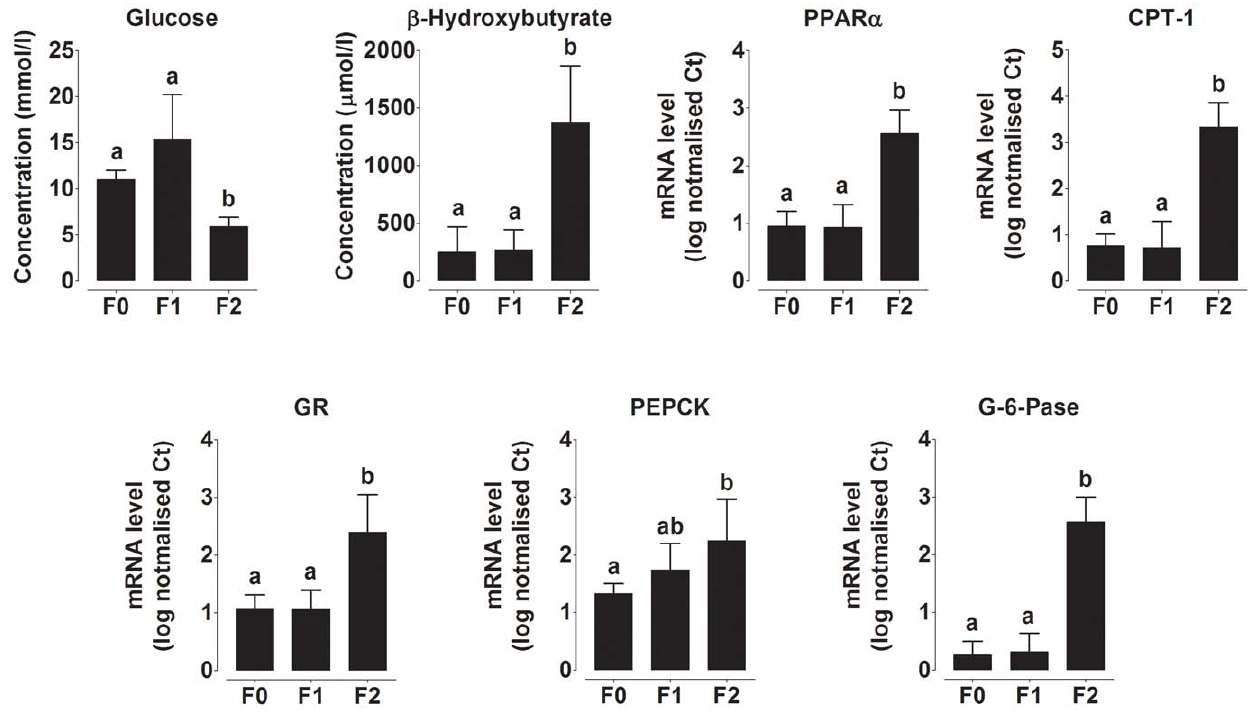
Figure 3. Maternal blood metabolite concentrations and mRNA expression of genes involved in hepatic gluconeogenesis and ketogenesis. Plasma fasting glucose and b -hydroxybutyrate concentrations. Hepatic PPAR a , carnitine palmitoyltransferase-1 (CPT-1), glucocorticoid receptor (GR), phosphoenolpyruvate carboxykinase (PEPCK), (G) glucose-6-phosphatase (G-6-Pase) mRNA expression. Values are mean 6 SD for n=5 2 7 rats per group. Values with different letters are significantly different (P , 0.05).